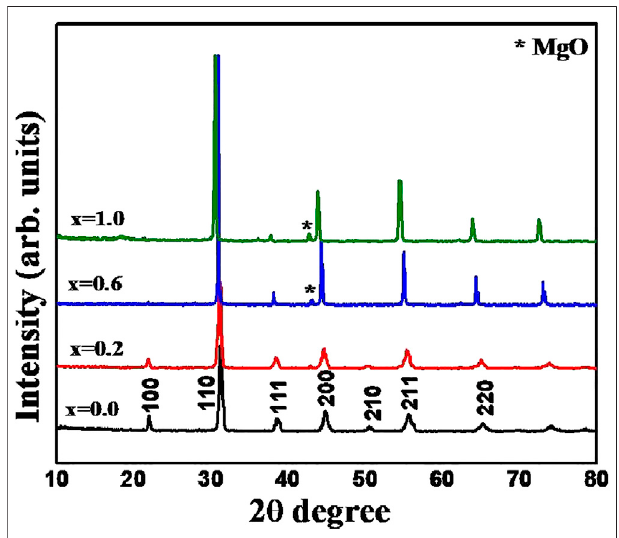
FIGURE 1 | XRD patterns of BaZr 0.2 [Ti (1-x) Mg x/3 Ta 2x/3 ] 0.8 O 3 solid solution with x (cid:1) 0.0, 0.2, 0.6 and 1.0